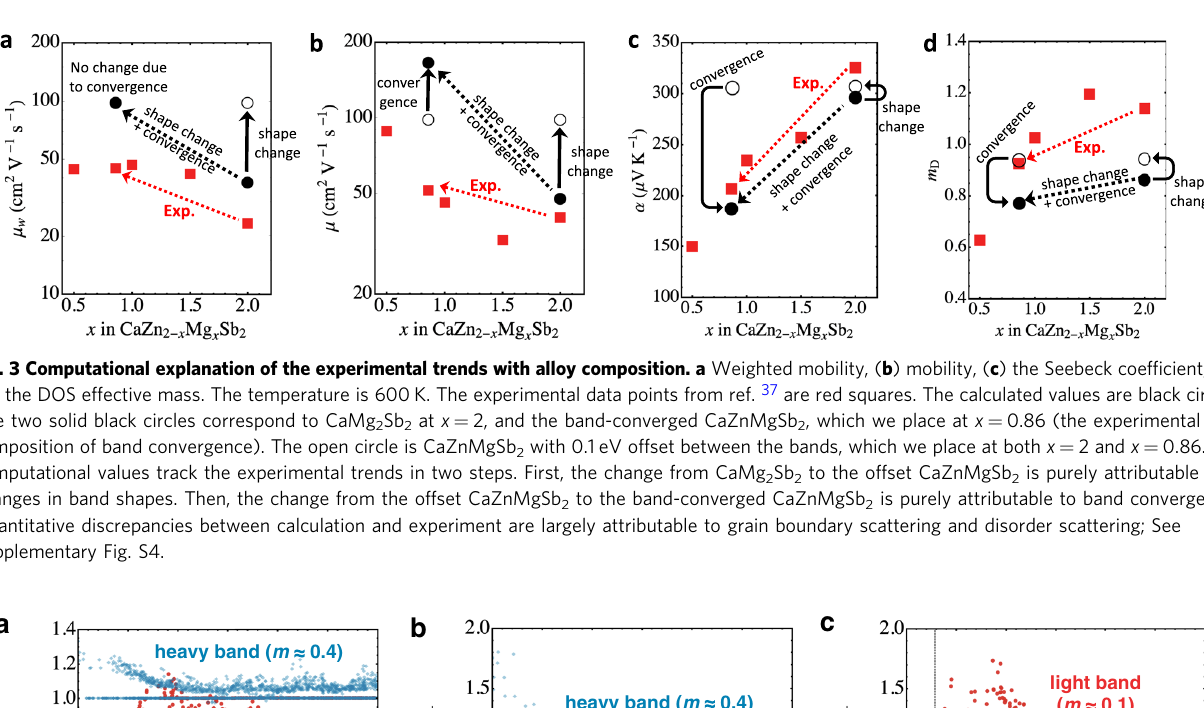
Figs. S6 – S8) and establish the generality of our fi ndings for the Zintl alloys.